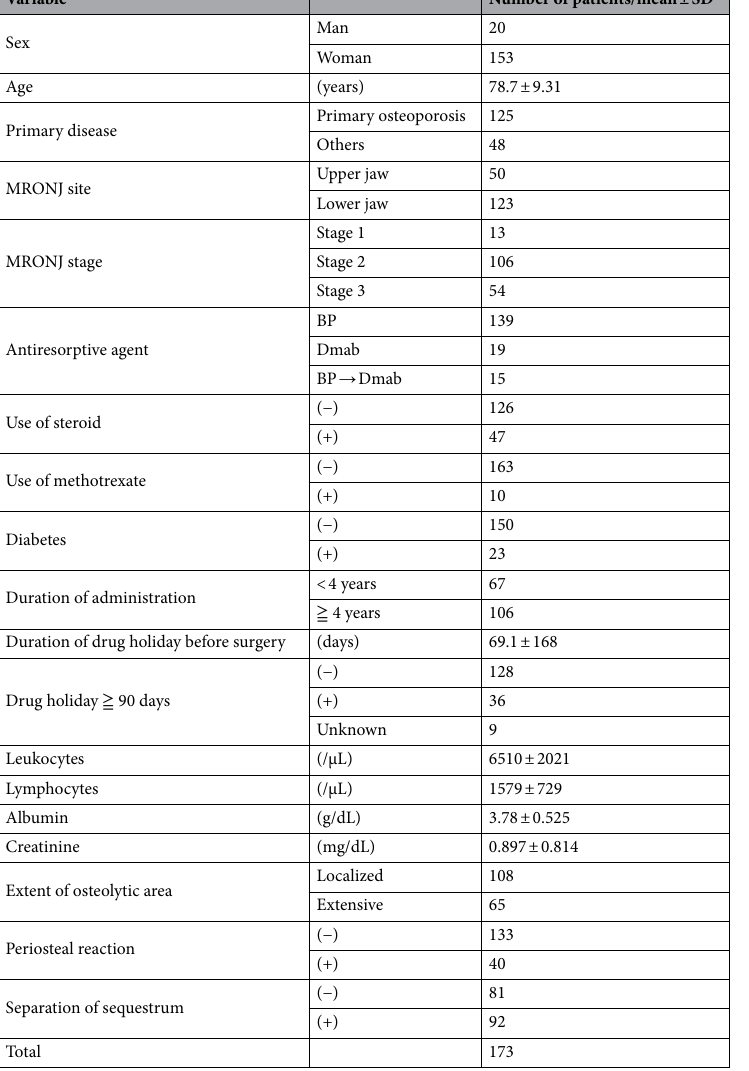
Table 1. Patient characteristics. BP: bisphosphonate, Dmab: